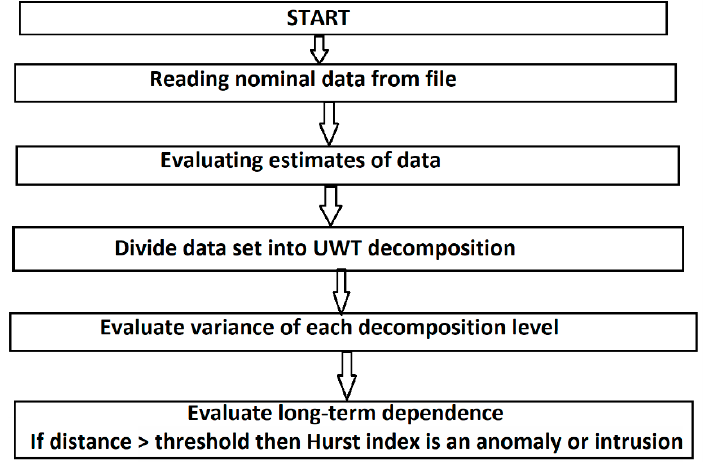
Figure 15. Algorithm’s flow for the proposed approach.